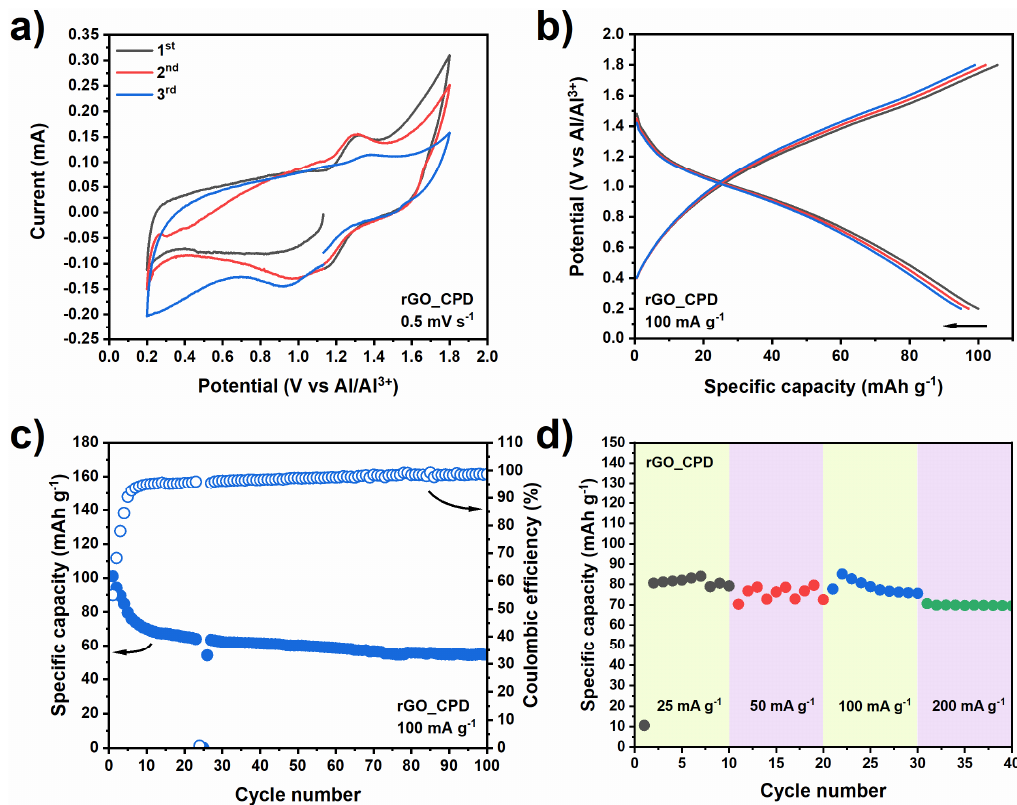
Figure 4. Electrochemical performance of the supercritically − dried reduced graphene oxide (rGO_CPD): ( a ) cyclic voltammetry, ( b ) charge − discharge voltage profiles, ( c ) cycling stability with Coulombic efficiency and ( d ) rate capability.